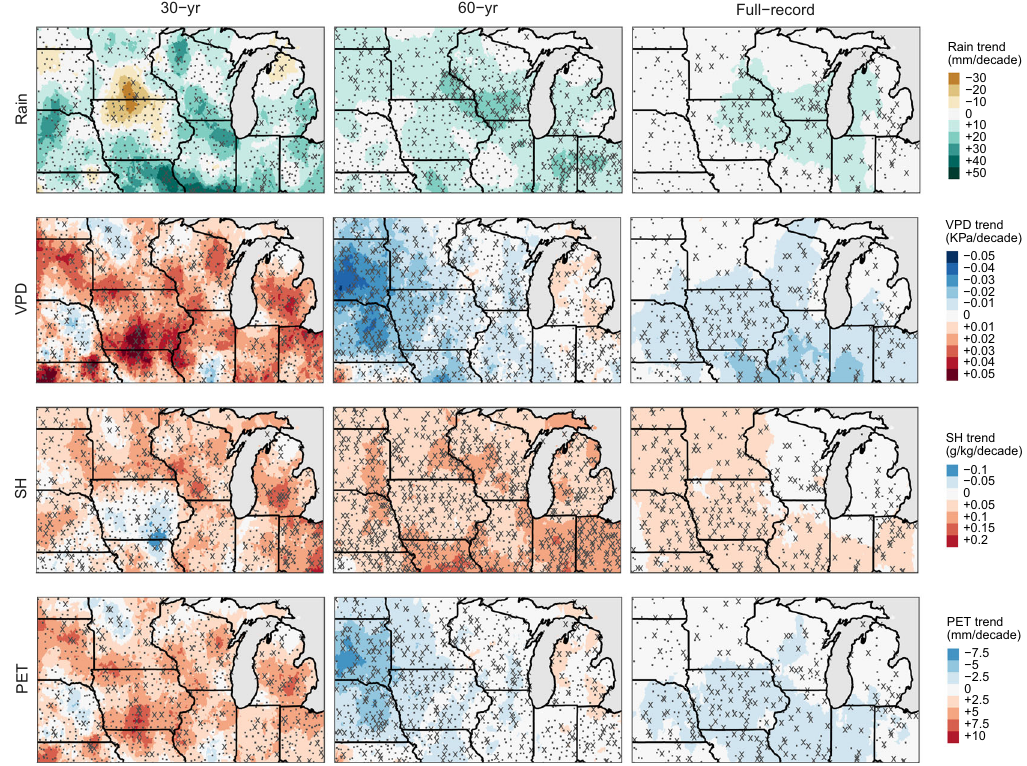
Fig. 3 Spatial patterns of local trends in mean summer (JJA) rain, speci fi c humidity (SH), vapor pressure de fi cit (VPD), and total summer potential evapotranspiration (PET) for the three time series. Stations marked with a cross ( x ) indicate signi fi cant local trends at the α = 0.1 level.